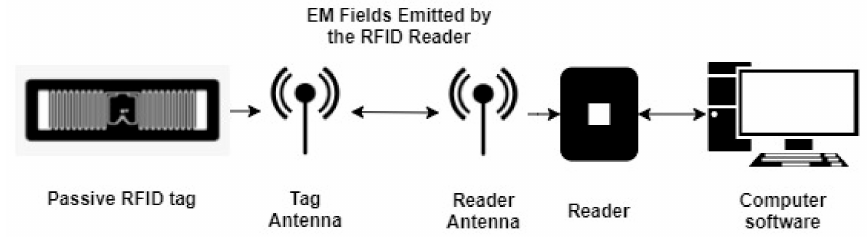
Figure 1. Scheme of information transmission from passive RFID Tag to RFID Reader.